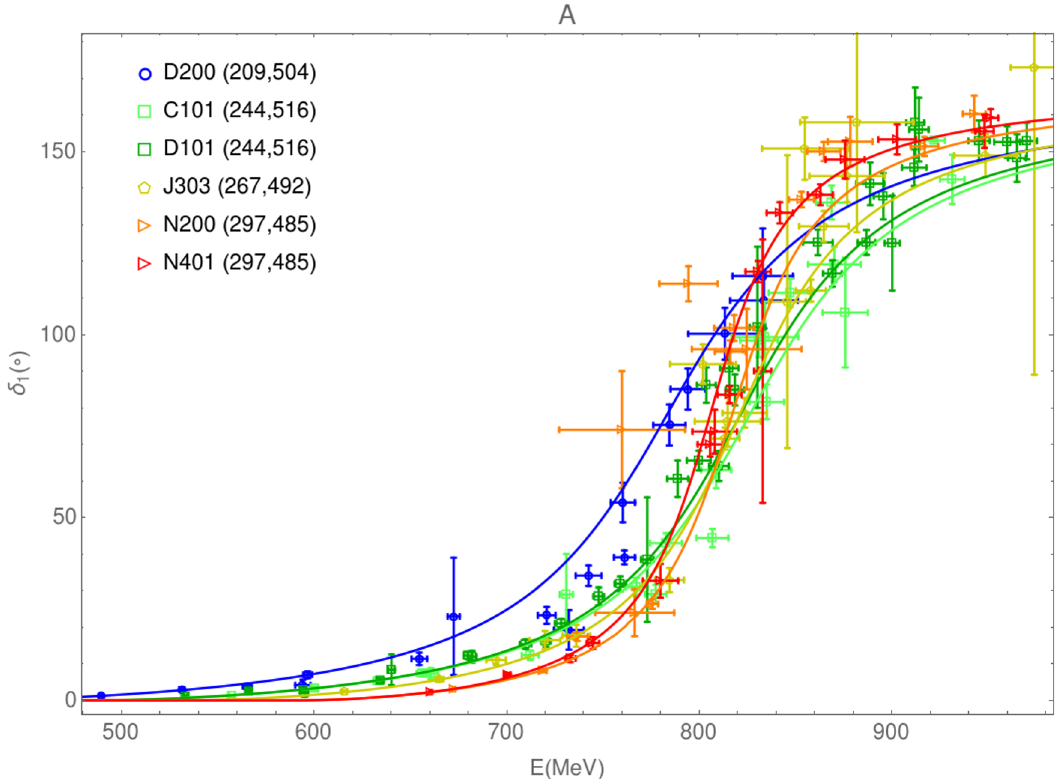
Figure 9 . Phase shift lattice data [81] and individual (cid:12)ts (depending of (cid:12) ) obtained with the scale setting A . The values in brackets stand for the pion and kaon masses (in MeV),